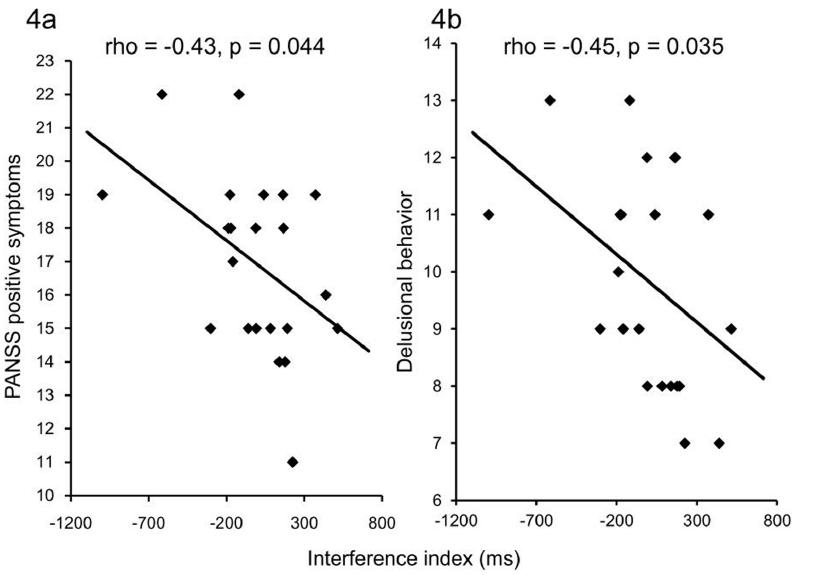
Figure 4. Relationships between the aberrant interference and positive symptoms, delusional behavior. Scatter plots depict correlations between the interference index for negative-right/neutral-left word pairs irrespective of attention side and severity of positive symptoms in the Positive and Negative Syndrome Scale (PANSS) (rho= 2 0.43, p=0.044) (a) and severity of delusional behavior (rho= 2 0.45, p=0.035) (b) in the patients with schizophrenia.